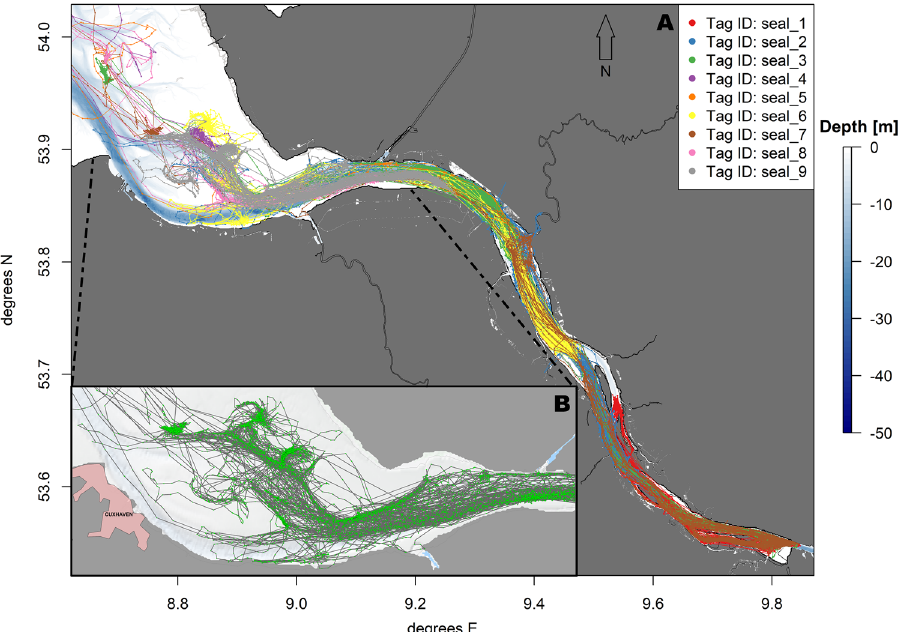
Figure 4. ( A ) Map with reduced extent showing the recorded tracks of nine harbour seals tagged in the Elbe estuary. Tracks are colour-coded by tag ID. ( B ) Focus map of the estuary near Cuxhaven. Green points: GPS locations, grey lines: tracks of the seals. Visualisation was done in R! 3.6.2 35 using R Studio 2021.9.0.351 for